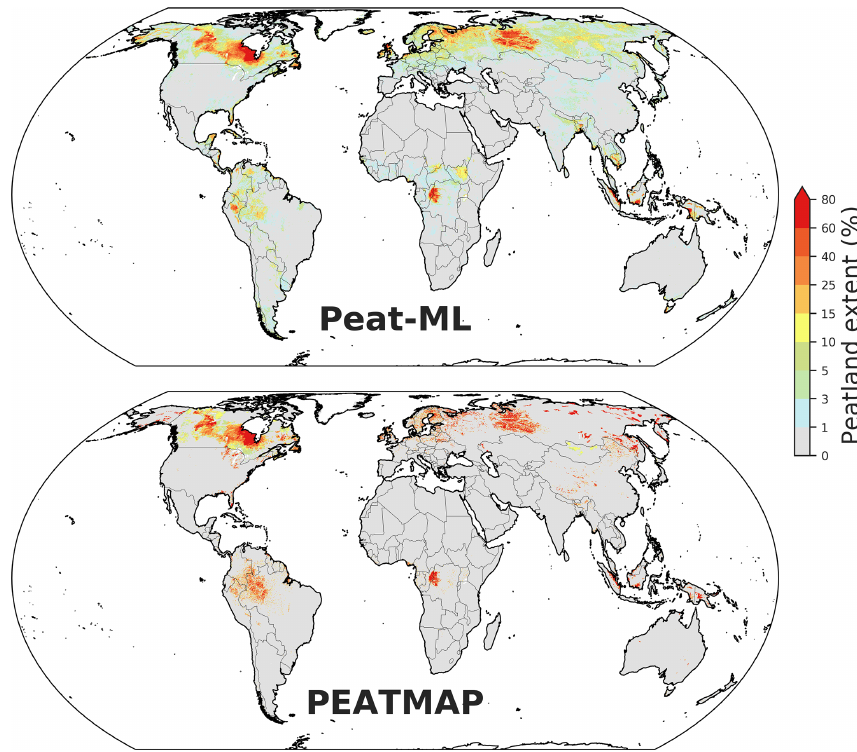
Figure 4. Global peatland extent as estimated by Peat-ML along with PEATMAP (Xu et al., 2018).